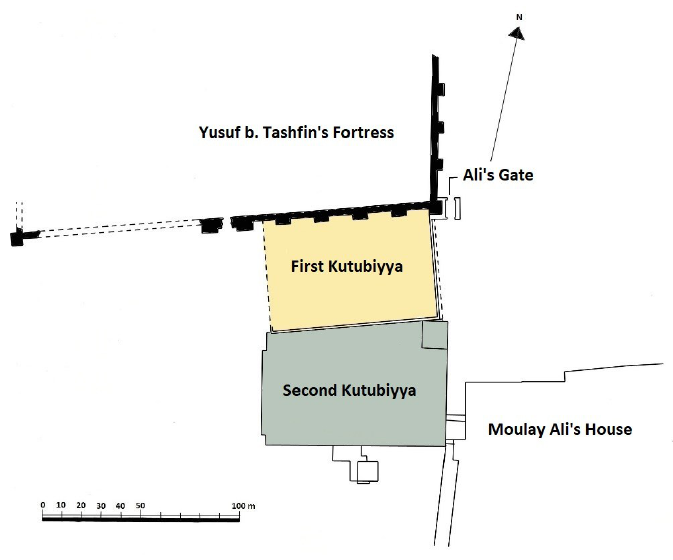
Figure 2. Drawing of the floor plan of the first and second Kutubiyya of Marrakech. Drawing made by author.